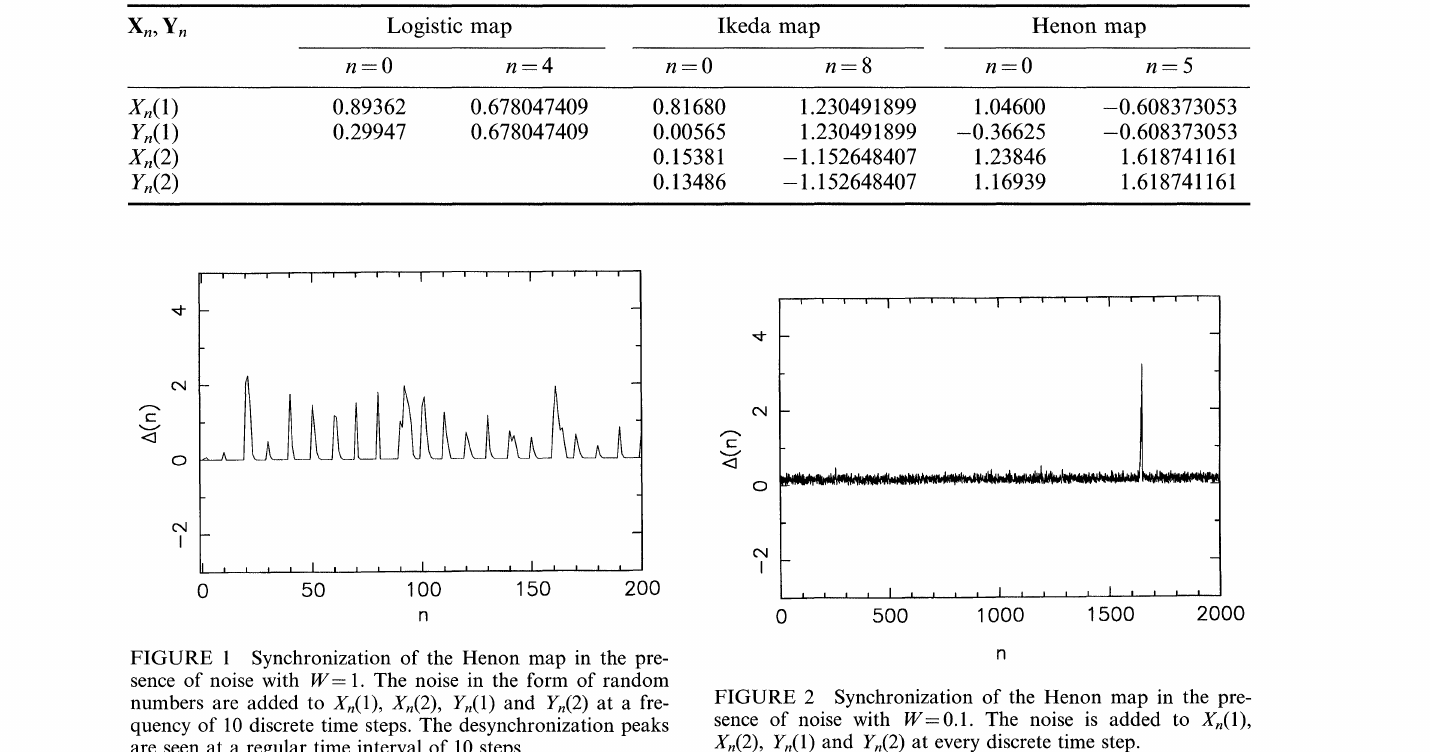
Synchronization of the Logistic map (Eqs. (9) and (10)), Ikeda map (Eqs. (11)-(20)) and Henon map (Eqs. (21)-(25)) in the absence of noise. The initial states are chosen from a random number generator. The table shows that synchronization occurs after n-4, 8 and 5 iterations in these maps respectively. Although the synchronized numbers quoted in the table are shown to agree to nine decimal places, they agreed to all figures in our double precision calculations. Some initial conditions required less and some required more than the quoted number of iterations to synchronize but in all the test cases synchroniza- tion were achieved within about 10 iterations Xn, Yn